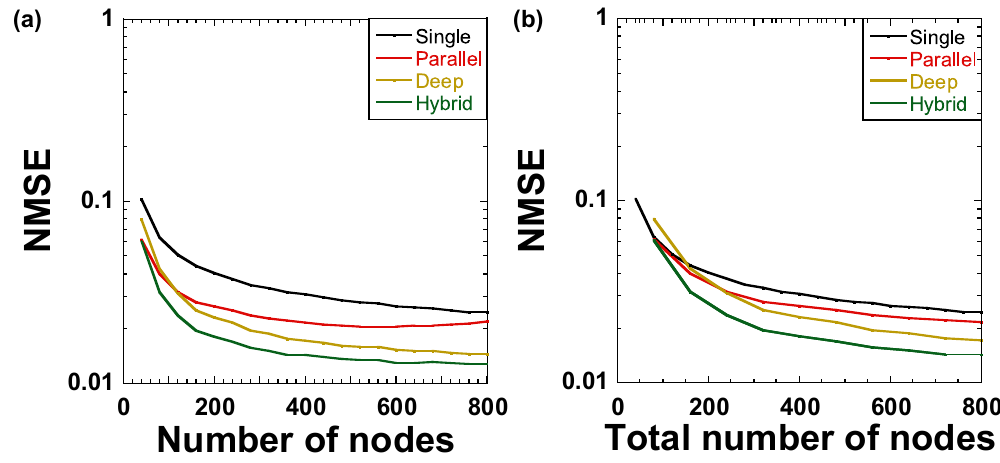
Figure 4: Normalized mean-square error (NMSE) of the chaotic time-series prediction task as a function of (a) the number of nodes N for each reservoir and (b) the total number of nodes N for all reservoirs for single (black), parallel (red), deep (brown), and hybrid (green) total is N for single configuration and 2 N for parallel, deep, and hybrid configurations. (b) N configurations. (a) N total